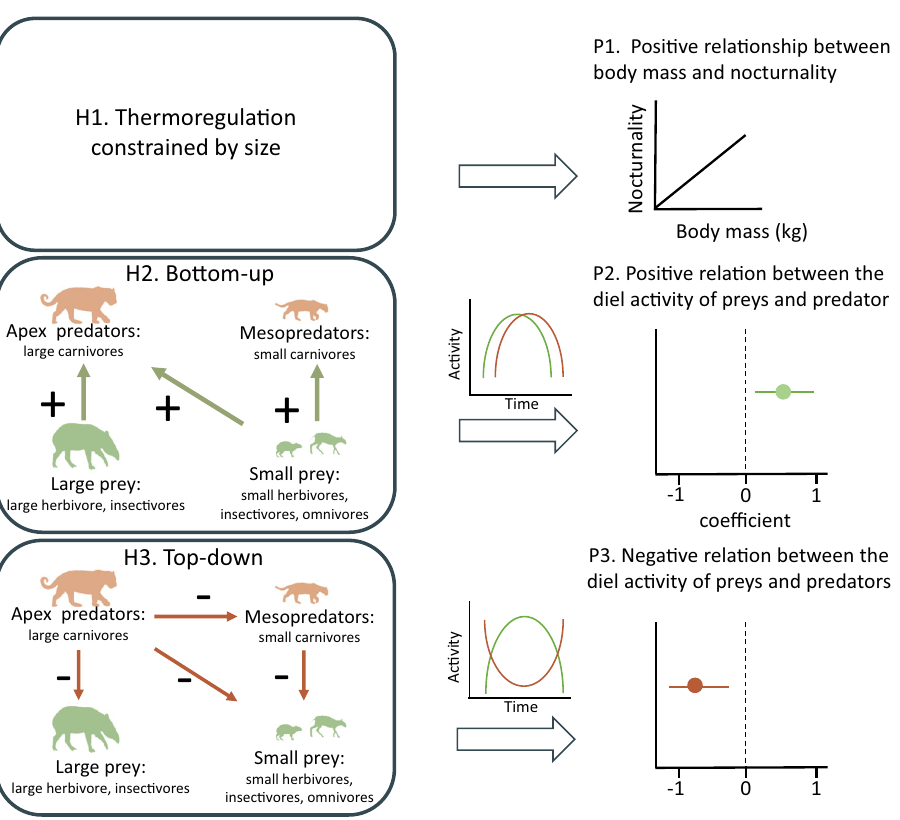
Fig. 1 | Hypotheses (H1 – H3) to determine processes that shape diel activity patterns in tropical forest mammal communities, with associated predictions (P1 – 3). If the energetic cost of thermoregulation dominates (H1), we expect a positive relationship between body mass and nocturnality (1), regardless of trophic guild. If bottom-up regulation dominates (H2), predators will follow the diel activity of their prey (2). If top-down regulation dominates (H3), then we predict that small predators and potential prey species (herbivores and